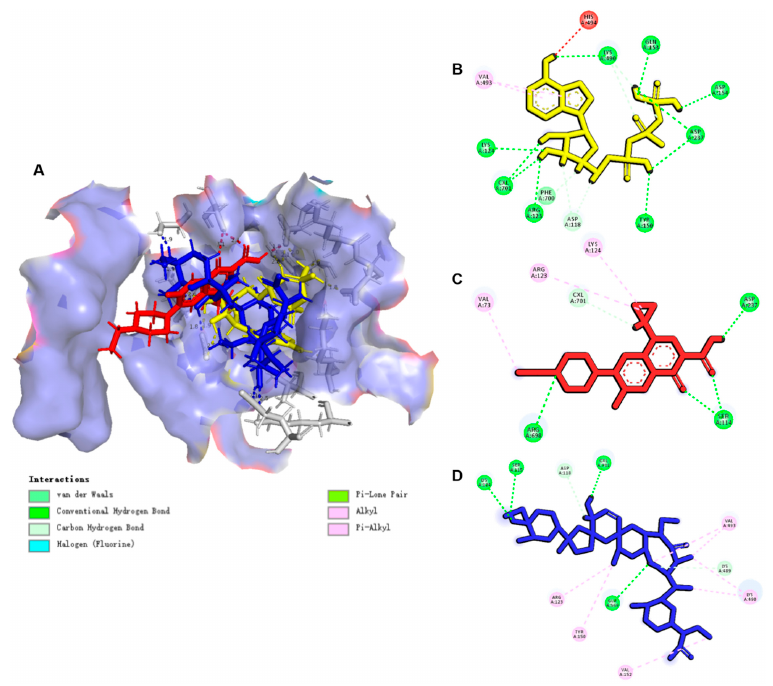
Figure 10. Molecule docking simulations of compounds with BCRP (PDB ID: 6ETI). ( A ) ENR (Red), SAL (Blue) and ATP (Yellow) in the active area of BCRP (PDB ID: 6ETI). ( B – D ) are 2D maps of the interaction of ENR, SAL and ATP with BCRP, respectively. The green dashed lines indicate hydrogen bonding forces between compounds and amino acid residues.